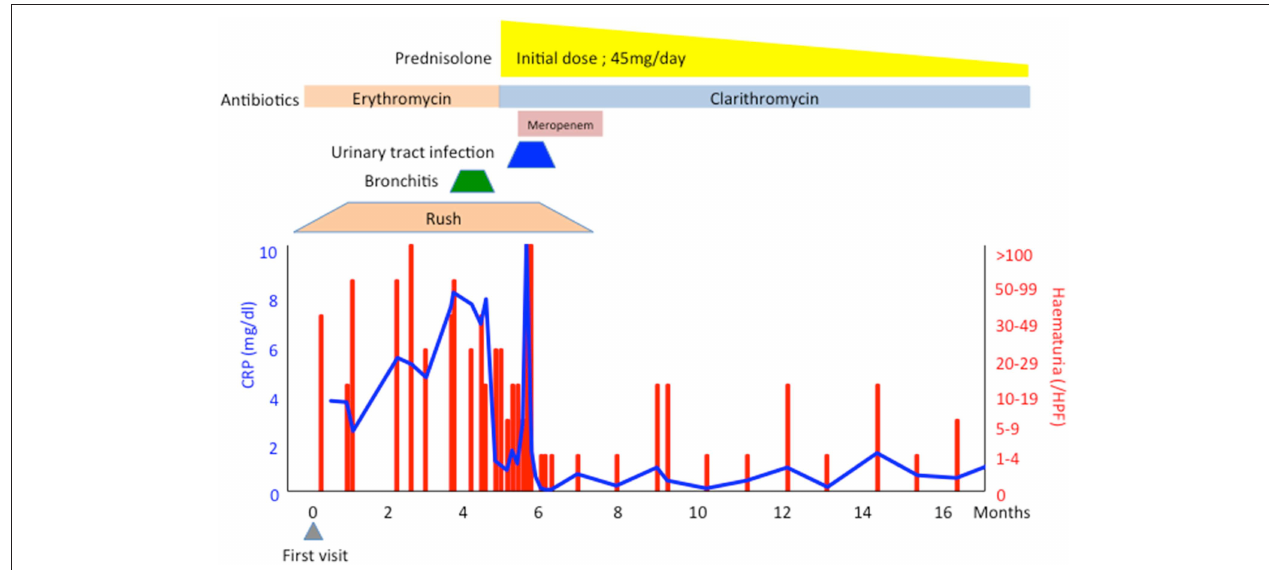
FIGURE 1 | Clinical course of a